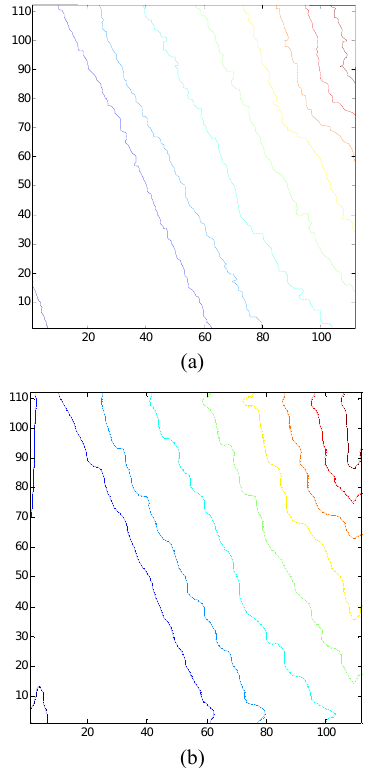
Figure 4 . Contour representation of the reference, 0.25 m sampling distance (a), and the 1 m sample data